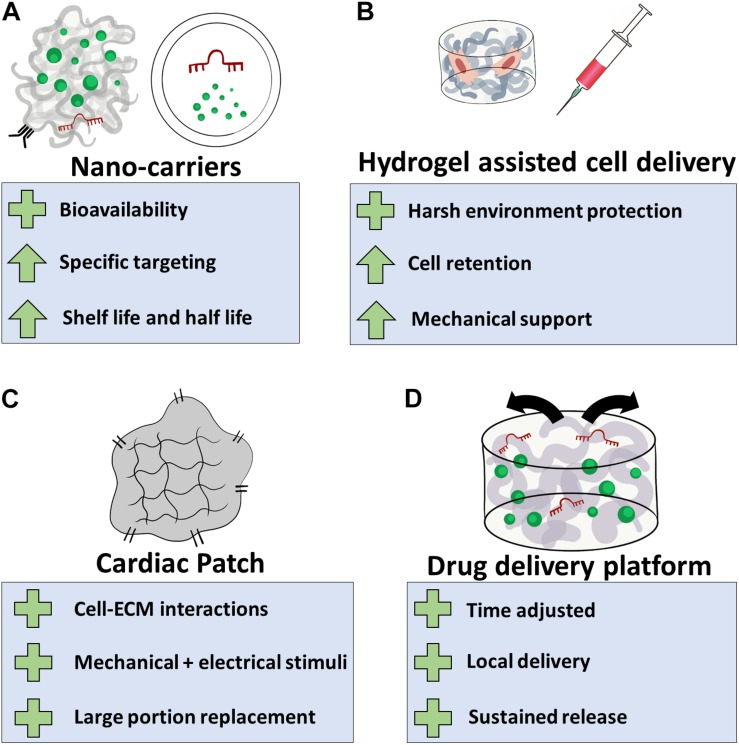
Biomaterial-based applications for cardiac regeneration. (A) Natural or synthetic polymers can be used as nano-carriers for the delivery of cardiac inducing agents. This will assist their bioavailability, allow specific targeting to the infarcted region or destination cell population, and increase their half-life in the tissue, eventually improving treatment efficacy; (B) hydrogel systems can be utilized to protect transplanted cells from the hostile post-MI microenvironment. This strategy can improve cell retention and provide the transplanted cells and the infarcted tissue the mechanical support lost as a result of massive loss of muscle tissue; (C) biomaterials can be used to fabricate cellular or acellular cardiac patches, providing cell with ECM interactions, mechanical and electrical stimuli. Depending on their size and mechanical properties, cardiac patches can perform as temporary or permanent replacements for damaged tissue; (D) regeneration-inducing agents can be encapsulated or bound to biomaterial-based delivery platforms, allowing effective release of these agents in a spatial–temporal manner. Plus sign indicates benefits of the application, arrow indicates an attribute that improves.